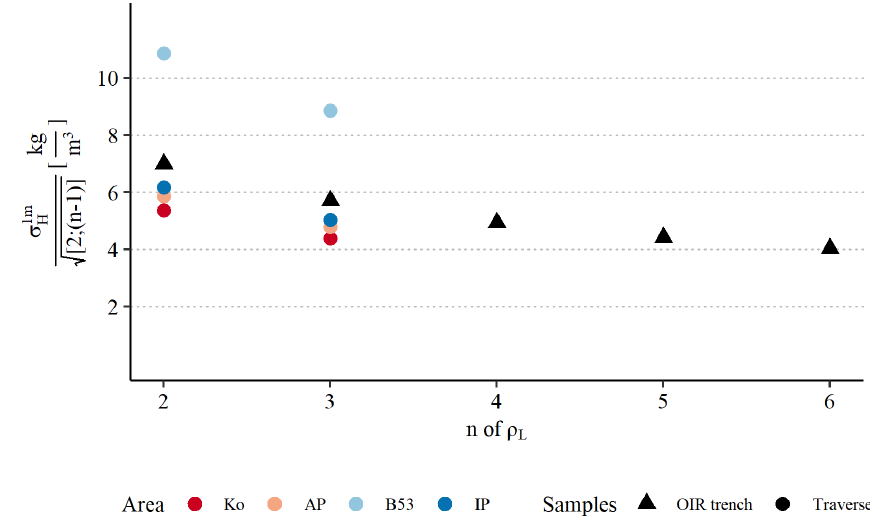
Figure 7. Standard error ( σ n ) of the location mean density ( ρ loc ) as a function of the number of profiles ( n ). Triangles represent samples from the OIR trench while colored circles show samples along the traverse in the respective subsets (Sect. 2.5).